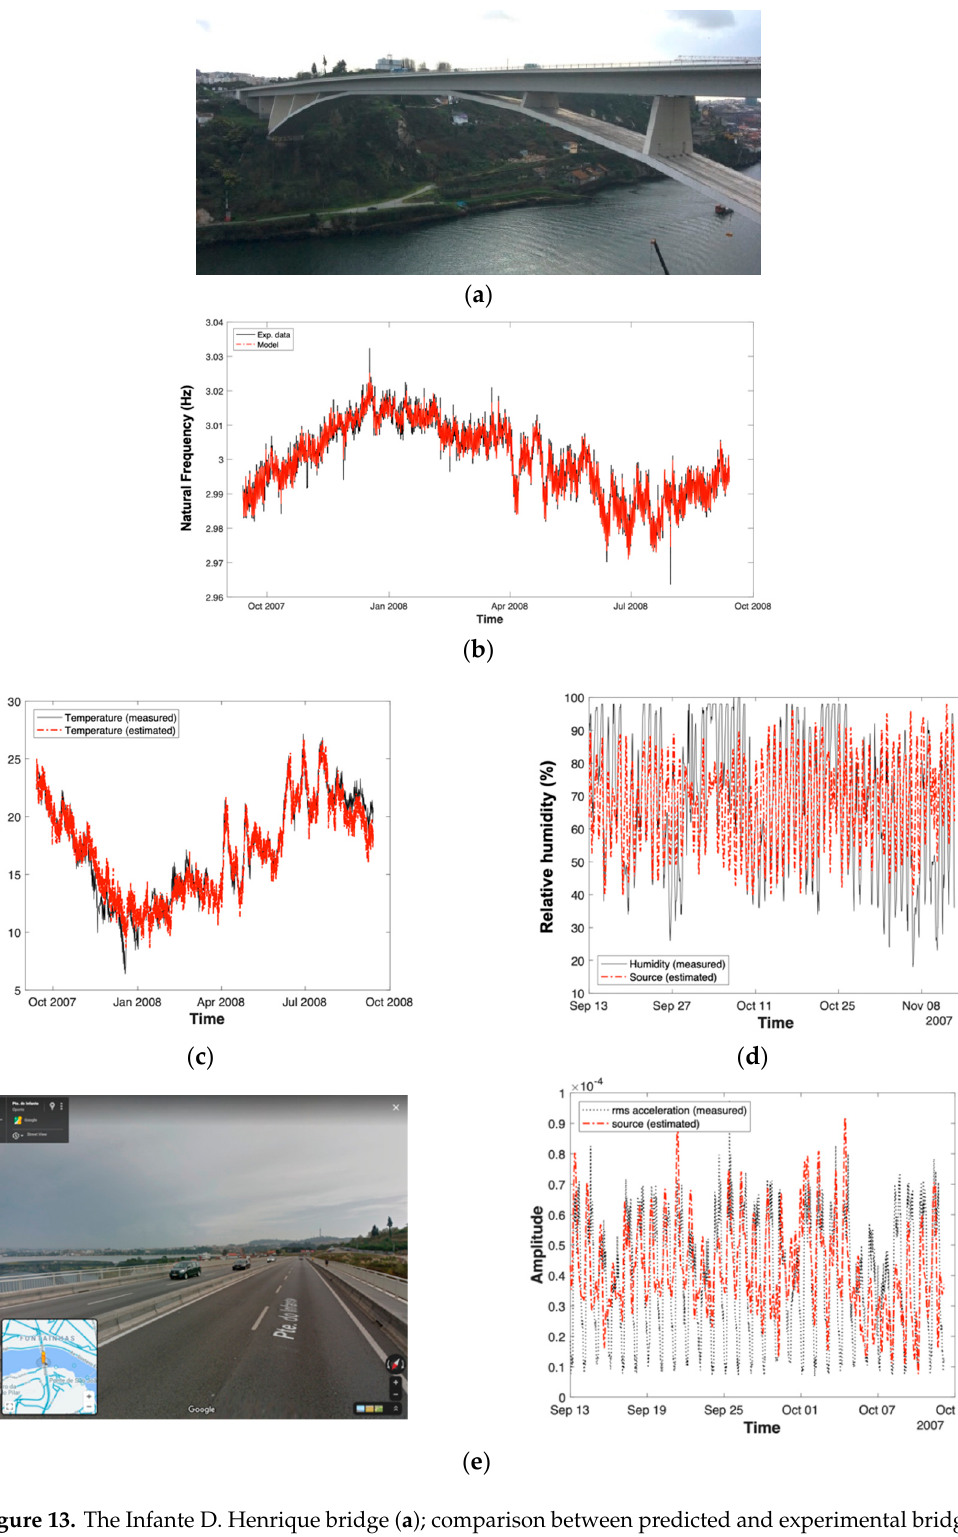
Figure 13. The Infante D. Henrique bridge ( a ); comparison between predicted and experimental bridge frequencies depending on time ( b ); patterns of relevant environmental and operational variables (EOVs) estimated by Second Order Blind Identification (SOBI): temperature ( c ), humidity ( d ), and traffic ( e ).